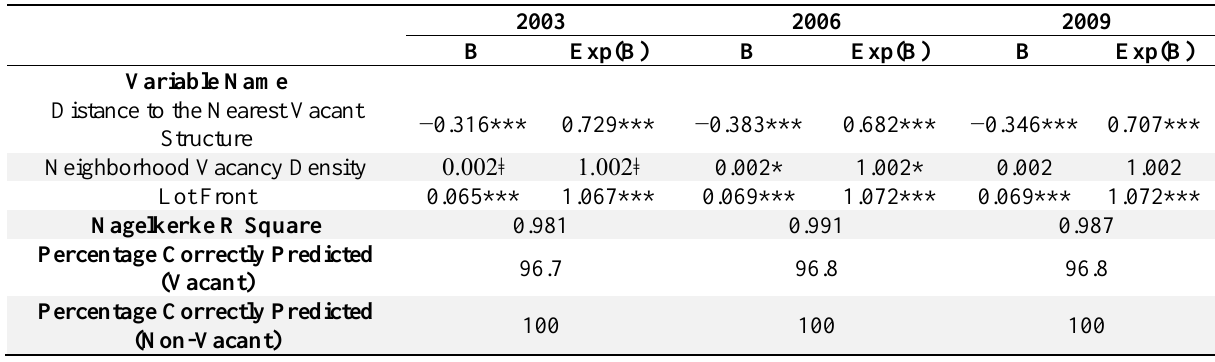
Table 4. Binary logistic regression model on vacancy and